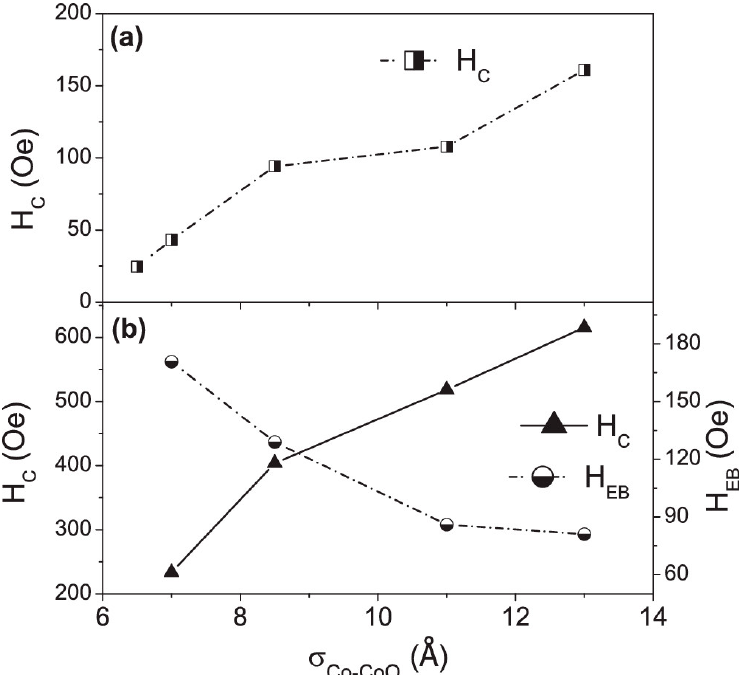
Figure 7. Increase of the coercive field H C ( a ) at room temperature and ( b ) after field cooling in 1.5 kOe to 153 K, and (b) decrease of the exchange bias field H EB under the same conditions with increasing interface roughness. Reprinted with permission from [87], Copyright 2016 AIP Publishing.